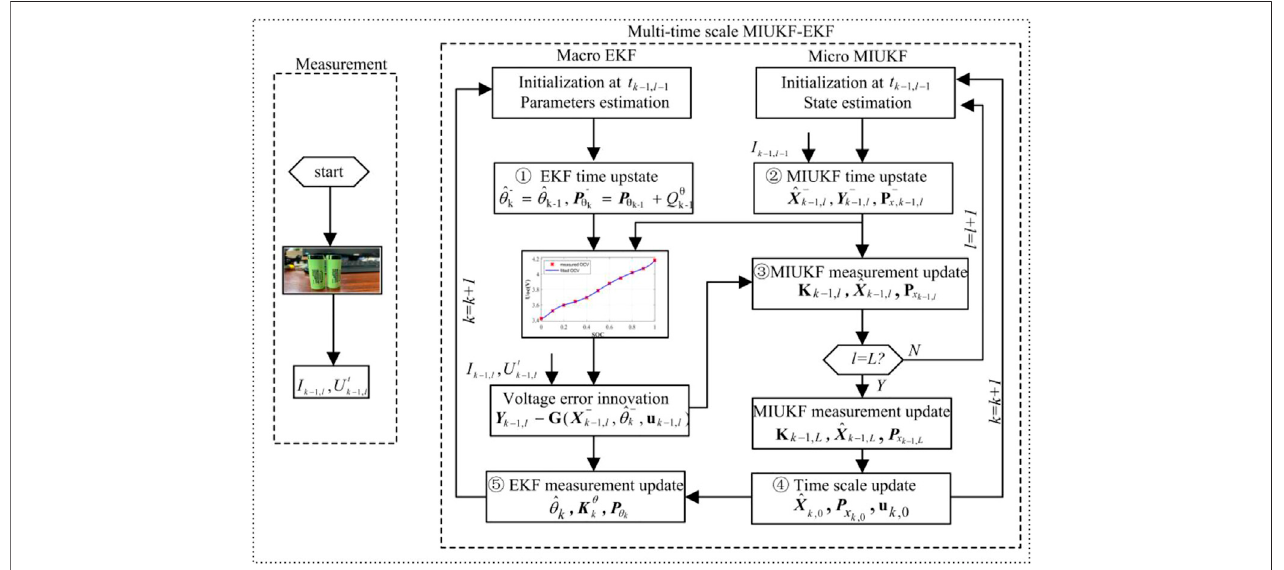
FIGURE 3 | Implementation structure of the multi-time scale MIUKF-EKF algorithm.